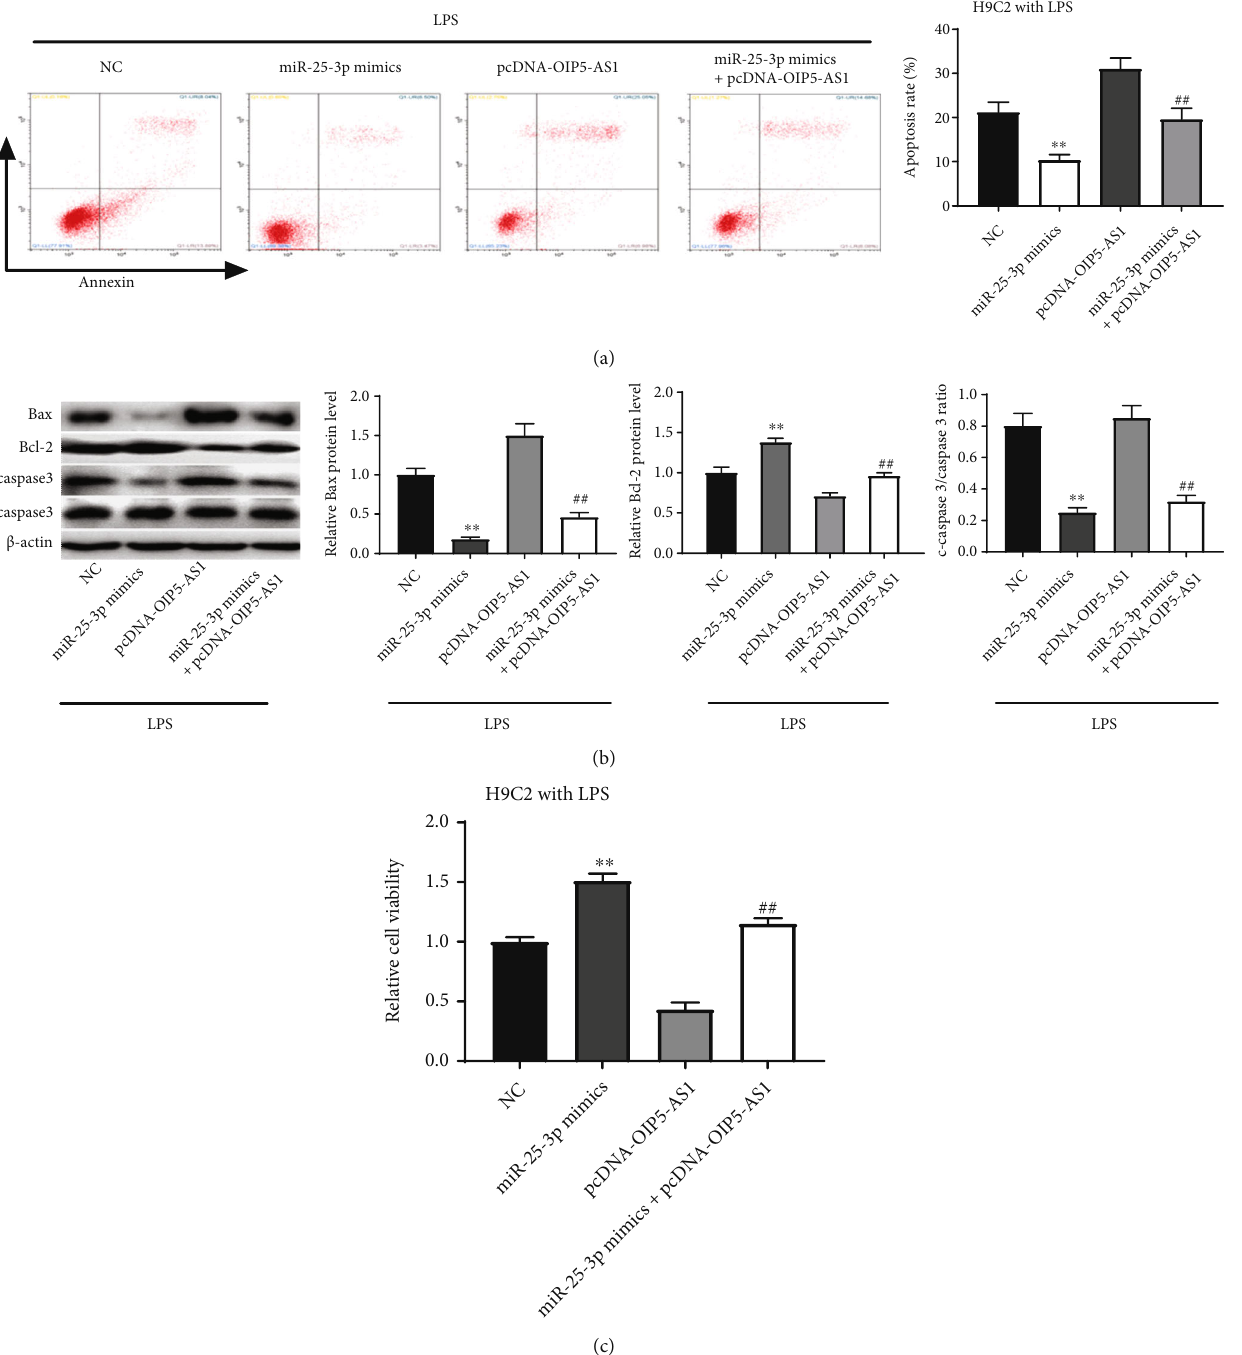
Figure 7: Overexpression of OIP-AS1 promotes cell apoptosis and represses cell proliferation via regulating miR-25-3p in LPS-treated H9C2 cells. (a) The apoptosis rate of LPS-induced H9C2 cells was determined by fl ow cytometry. (b) The protein expression of Bax, Bcl- 2, caspase3, and c-caspase3 in LPS-treated H9C2 cells was determined by western blot. (c) Cell viability of H9C2 cells was detected by MTT. ** P < 0 : 01 versus NC. ## P < 0 : 01 versus compared with the controls ( P < 0 : 01 ). The transfection of NOX4 WT and miR-NC ( P < 0 : 01 ; Figure 8(b)), illustrating miR-25-3p mimics signi fi cantly decreased the high expres- the target relationship between NOX4 and miR-25-3p. In sion of NOX4 and p-NF- κ B p65/NF- κ B p65 in LPS- addition, the protein expression of NOX4 and p-NF- κ B induced H9C2 cells ( P < 0 : 01 ; Figure 8(c)). p65/NF- κ B p65 was elevated in LPS-induced H9C2 cells